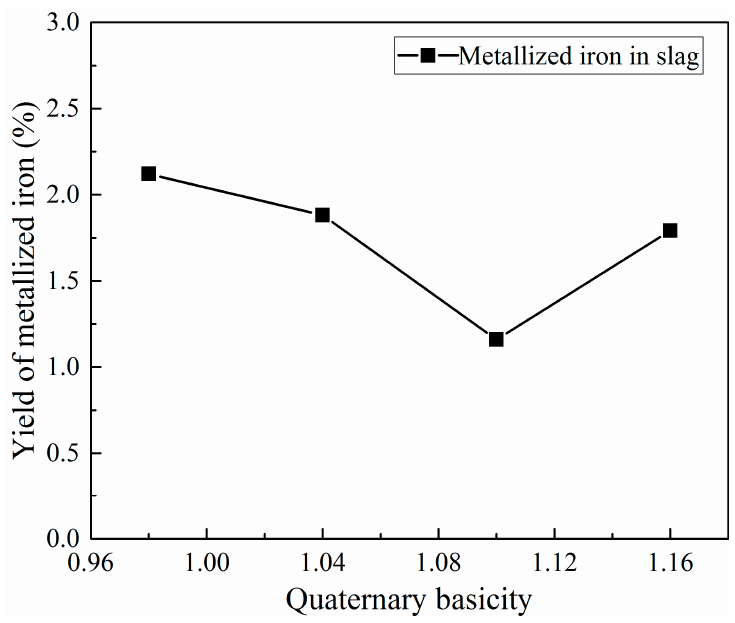
Figure 11. Effects of quaternary basicity by addition of CaO on yield of residual metallized iron in slag.